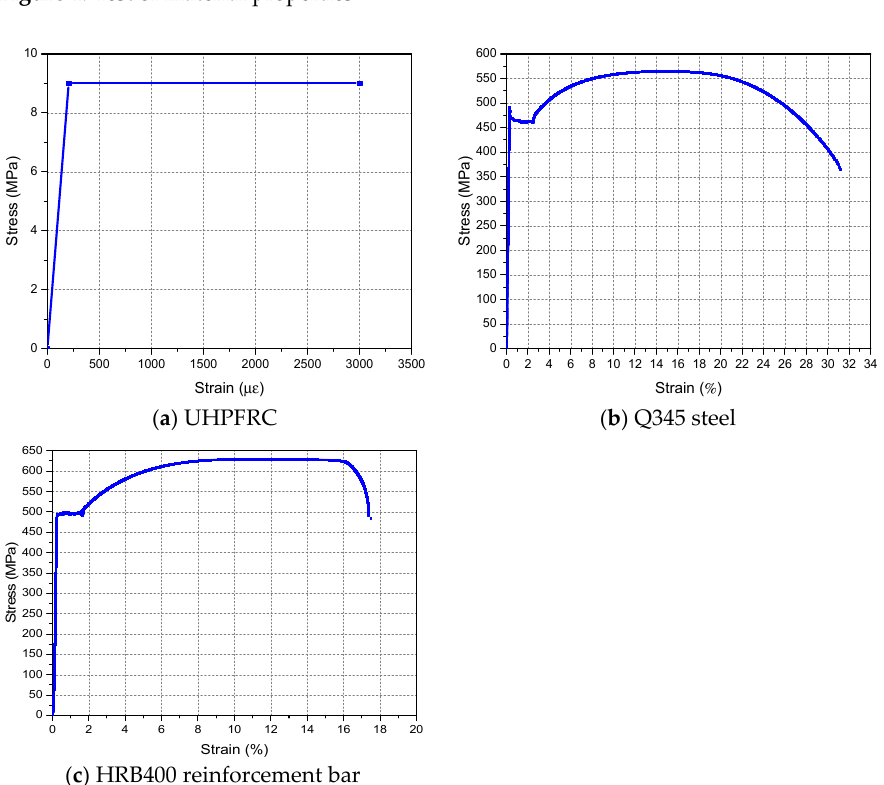
Figure 5. Stress-strain curves of materials in tension.